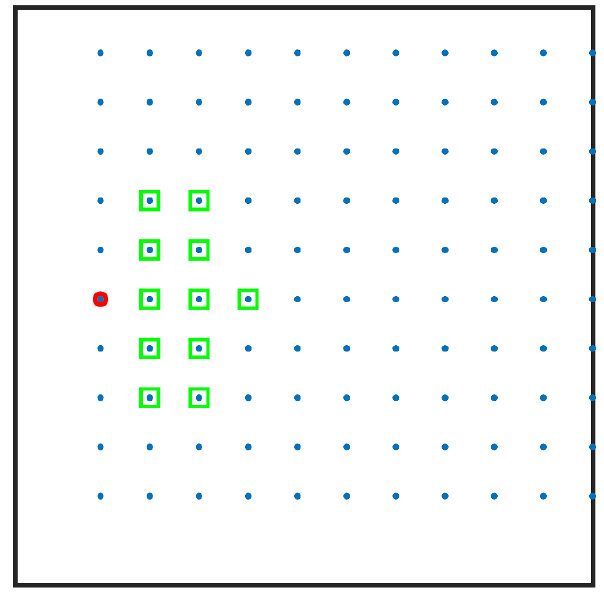
Figure 2. Outline of the support domain used for imposing no-flux boundary conditions. A boundary node is denoted with a red circle, and the corresponding nodes in its support domain with green squares.